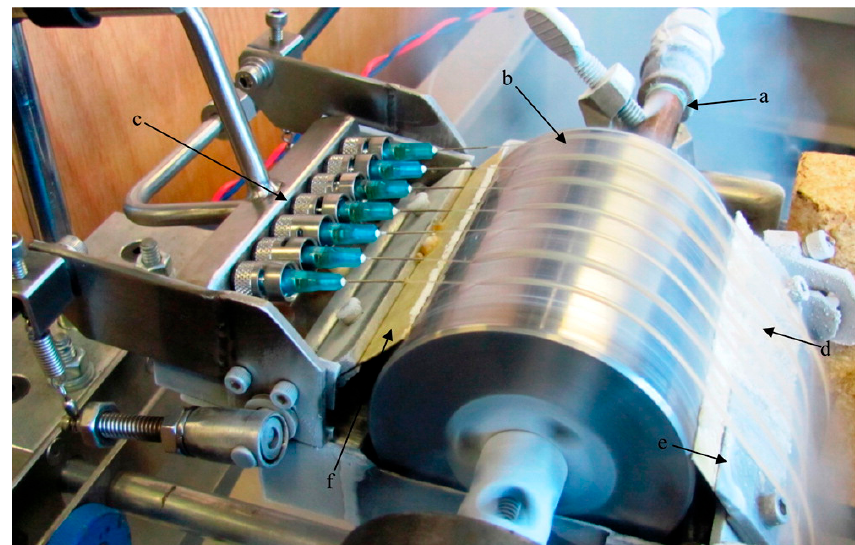
Figure 10. Image of the rapid freezing device for polymeric nanofiber production. ( a ) Liquid nitrogen supply ( b ) Steel drum rotating at ∼ 300 rpm; ( c ) Needles delivering lignin solution to the drum; ( d ) Ribbons of frozen solution containing the templated nanoscale lignin matrix; ( e ) Blade to ensure release of the frozen ribbons; ( f ) Spring tension-loaded wiper blade regulating the thickness of the liquid nitrogen layer present on the drum surface. Reprinted with permission from Spender et al. [97]. Copyright 2012 American Chemical Society.